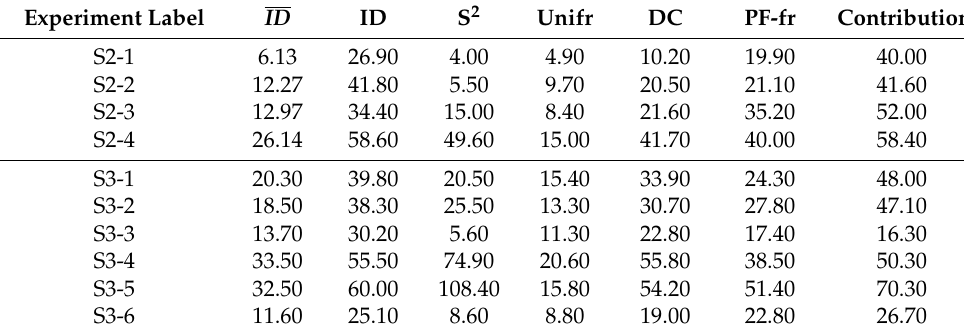
Table 4. Characteristics (i.e., ID, Unifr, Contribution etc.) of soil preferential flow. Experiment